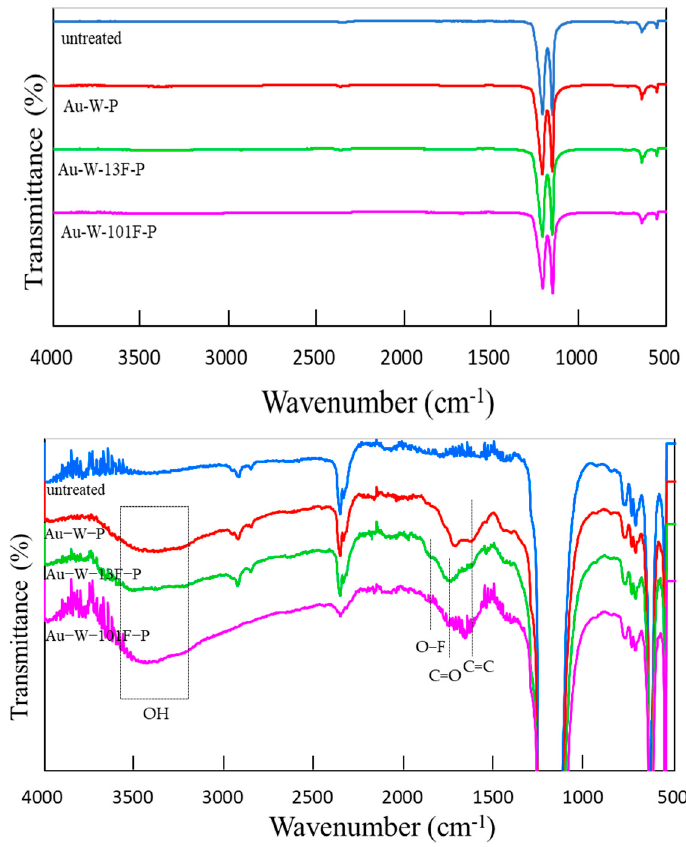
Figure 6. FTIR spectra of various PTFE samples.